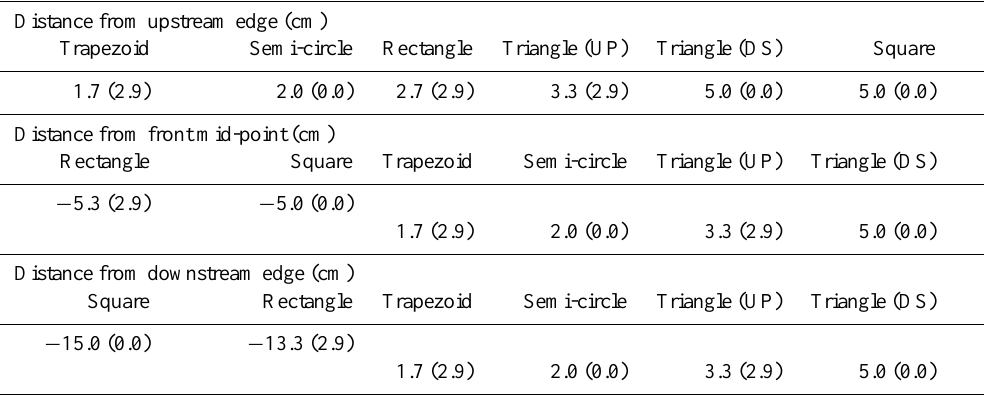
Table 5. Comparison of means results for obstruction shape versus distance from constriction to the pool center. The distance from the maximum width of the constriction is defined differently for each analysis. Mean values contained within the same horizontal line are not significantly different from each other. Values in parentheses are the corresponding standard deviations.